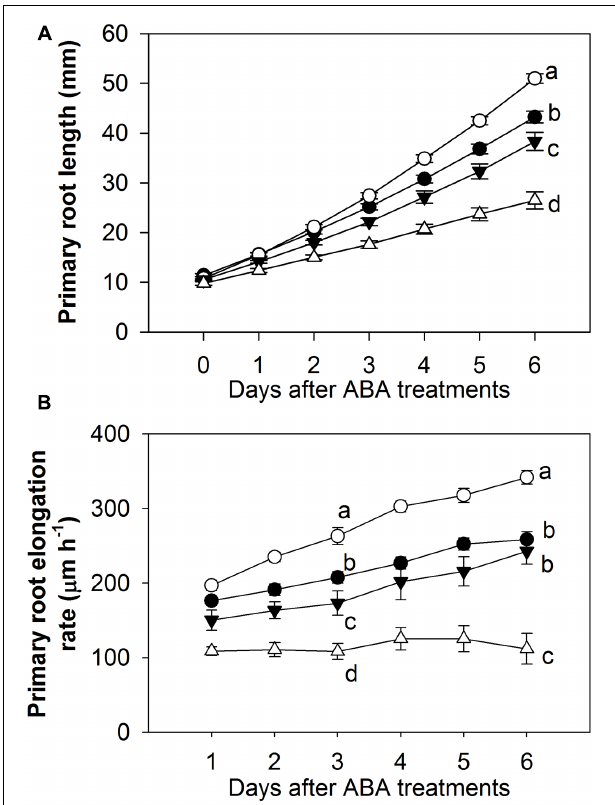
FIGURE 1 | Biphasic effect of applied exogenous ABA on the growth of primary root over the 6-day treatments. (A) Total primary root length. (B) Primary root elongation rate. Four-day old Arabidopsis wild-type Col-8 seedlings with similar root length were chosen and transferred to newly made 0.02 × B5 medium (1 mM KNO 3 , 0.5% sucrose) with various ABA concentrations (black circle, control; white circle, 0.1 µ M ABA; black triangle, 1 µ M ABA; white triangle, 10 µ M ABA). Primary root length was marked after transplanting and the increase of primary root were measured every day. The root elongation rate was calculated for each day. The values are means, and the vertical bars represent standard errors. Data analysed using one-way ANOVA with Tukey’s post hoc test and different letters indicate significant differences among ABA treatments in the same day at P < 0.05. Eta 2 of one-way ANOVA: (A) 0.776 (day 6); (B) 0.694 (day 3); 0.737 (day 6). Seedling numbers: control, n = 14; 0.1 µ M ABA, n = 9–14; 1 µ M ABA, n = 10–14; 10 µ M ABA, n = 11–14. At least three independent experiments were performed and similar results obtained and